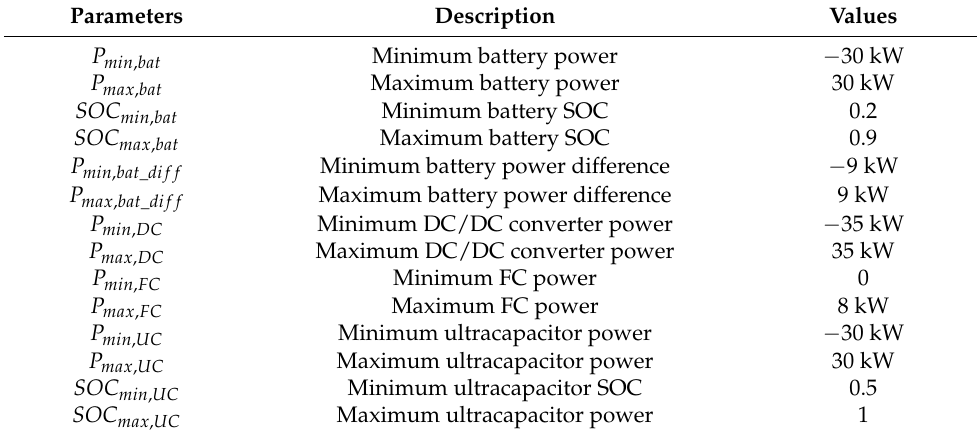
Table 6. Optimization constraints parameters.